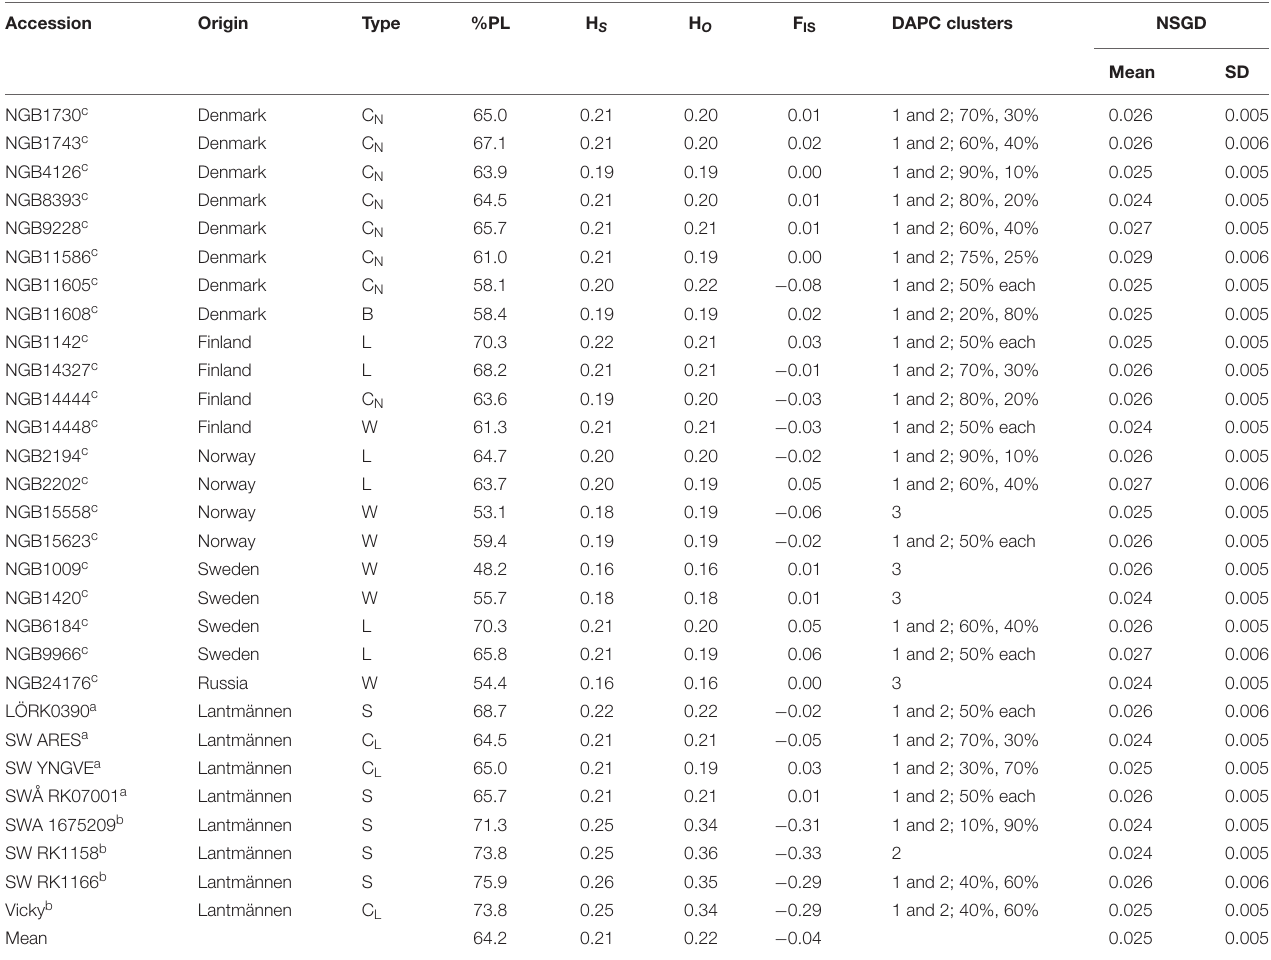
TABLE 1 | Summary of the accessions with origin, type (B = breeding population, C L = cultivar from Lantmännen, C N cultivar from NordGen, L = landrace population, S = synthetic population, W = wild population), percent polymorphic loci (%PL), within population diversity (H S ), observed heterozygosity (H O ), inbreeding coefficient (F IS ), discriminant analysis of principal components (DAPC) cluster designation and Nei’s standard genetic distance